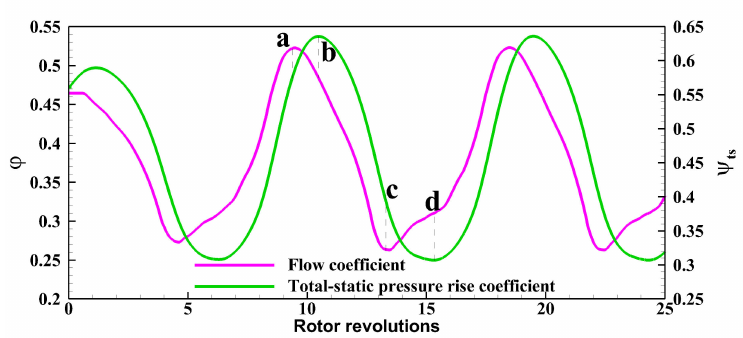
Figure 18. The flow coefficient as well as the total-static pressure rise coefficient during surge.